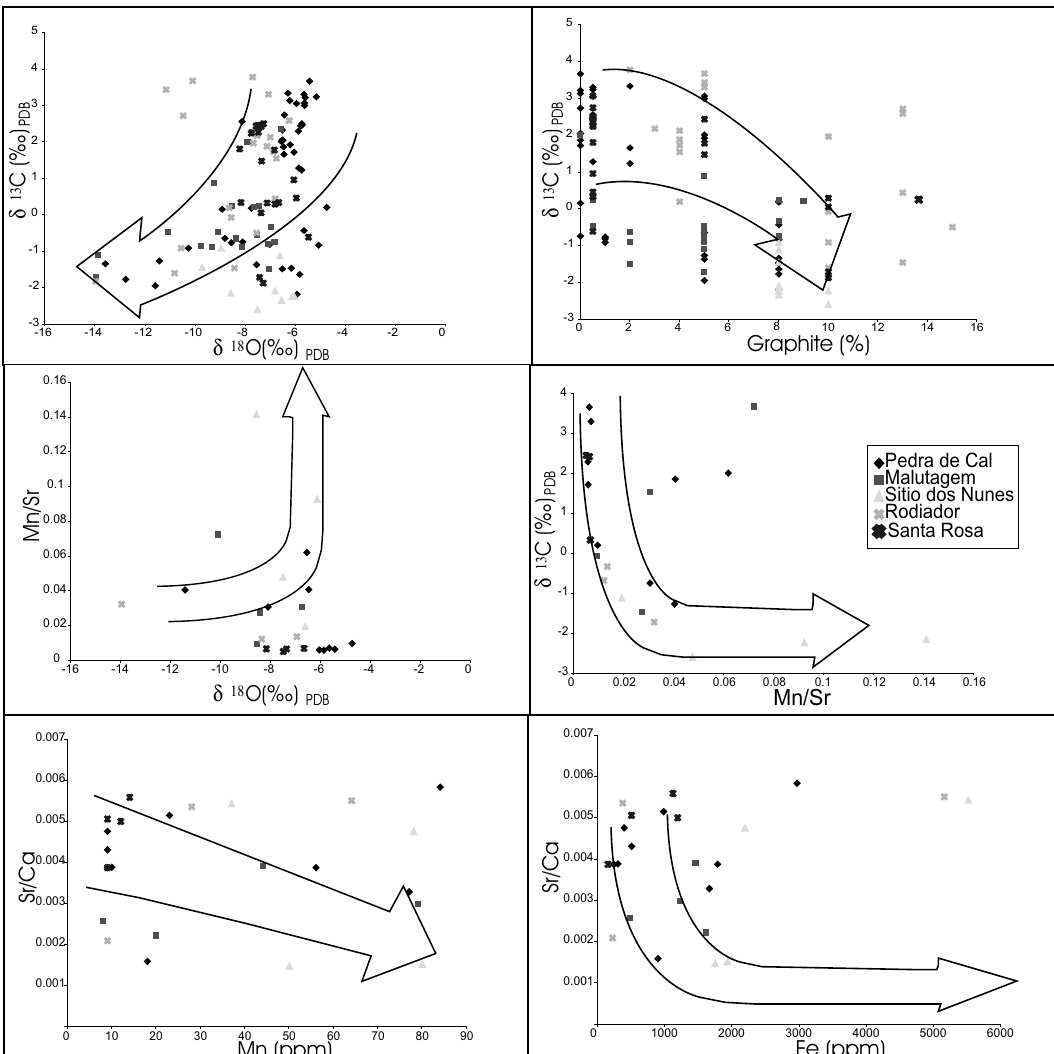
Fig. 4–Cross-plotsofisotopicandelementaldatafromallstudiedstratigraphicsections. Arrowsindicategeochemicalpostdepositional alteration trends, showing that most samples fall in the unaltered fields. Geochemical trends were used as proposed by Derry et al. (1992), Kaufman et al. (1991, 1993) and Kaufman and Knoll